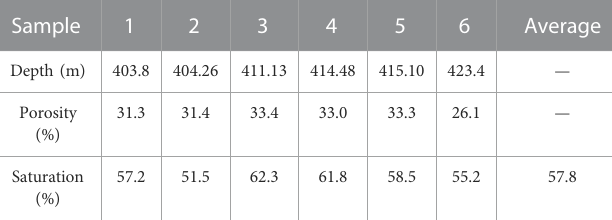
TABLE 1 Measured porosity and oil saturation of the core samples from well